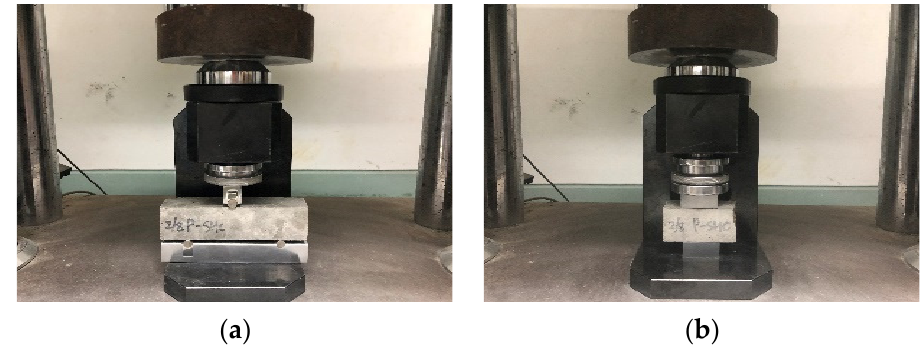
Figure 7. Experiment view: ( a ) flexural strength test; ( b ) compressive strength test.